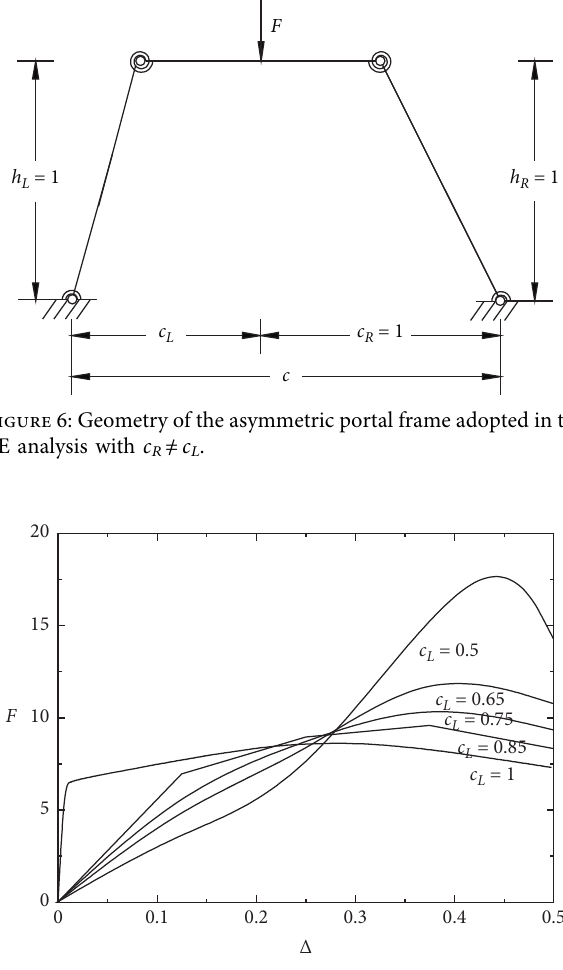
Figure 7: Load-displacement curves of a frame with c R � h R � h L � 1, e � 0, and changing c L .